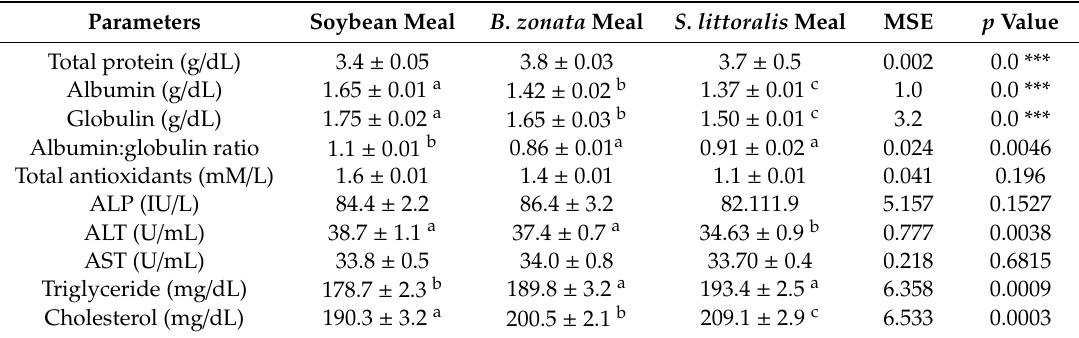
Table 7. Blood profile and hormonal level of Japanese quails at 45 days of age after feeding trials with three di ff erent